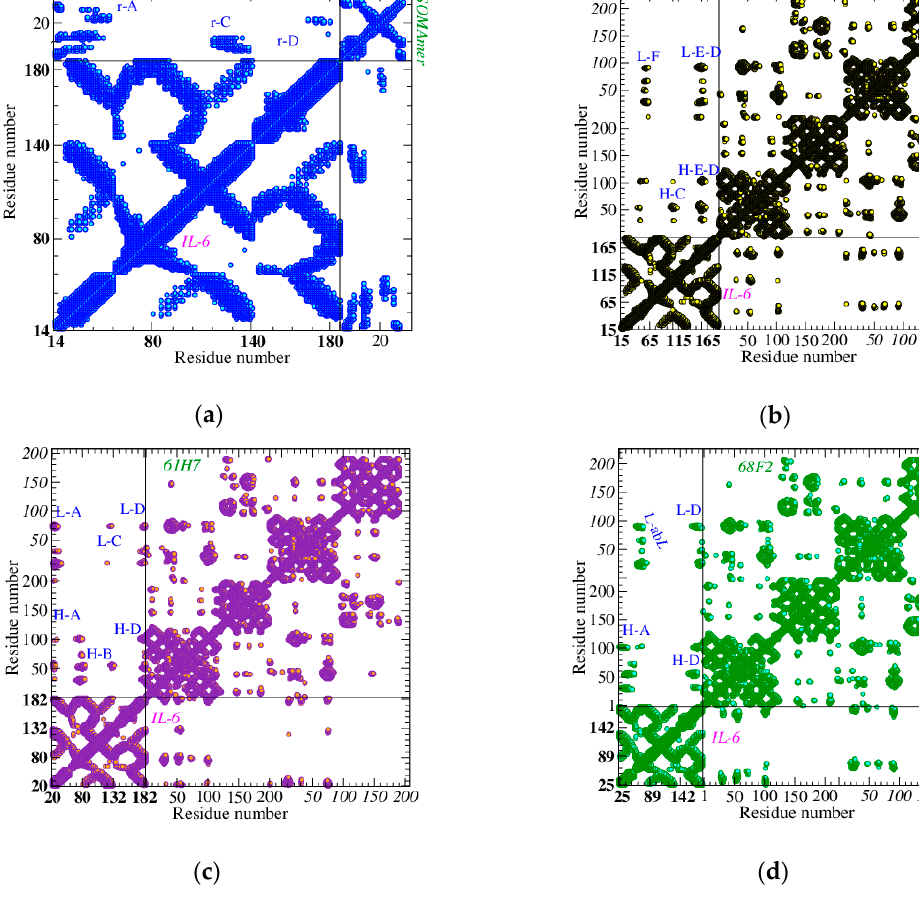
Figure 5. Contact maps of IL-6 complexed with di ff erent receptors, D = 15 Å. ( a ) SOMAmer SL1025: main links between the receptor (r) and helices A, C, and D are indicated; ( b ) Fab OKZ: main links between four IL-6 helices, C, D, E, F and the heavy (H) and light (L) chain of the receptor are indicated; ( c ) Fab 68F2: main links between IL-6 helices A and D and the heavy (H) and light (L) chain of the receptor are indicated; ( d ) Fab 61H7: main links between IL-6 helices A and D and the heavy (H) and light (L) chain of the receptor are indicated. Helices B and C show contacts with chains H and L, respectively. Progressive node numbers are indicated for IL-6 (bold), receptor heavy chain (normal), and receptor light chain (italic).